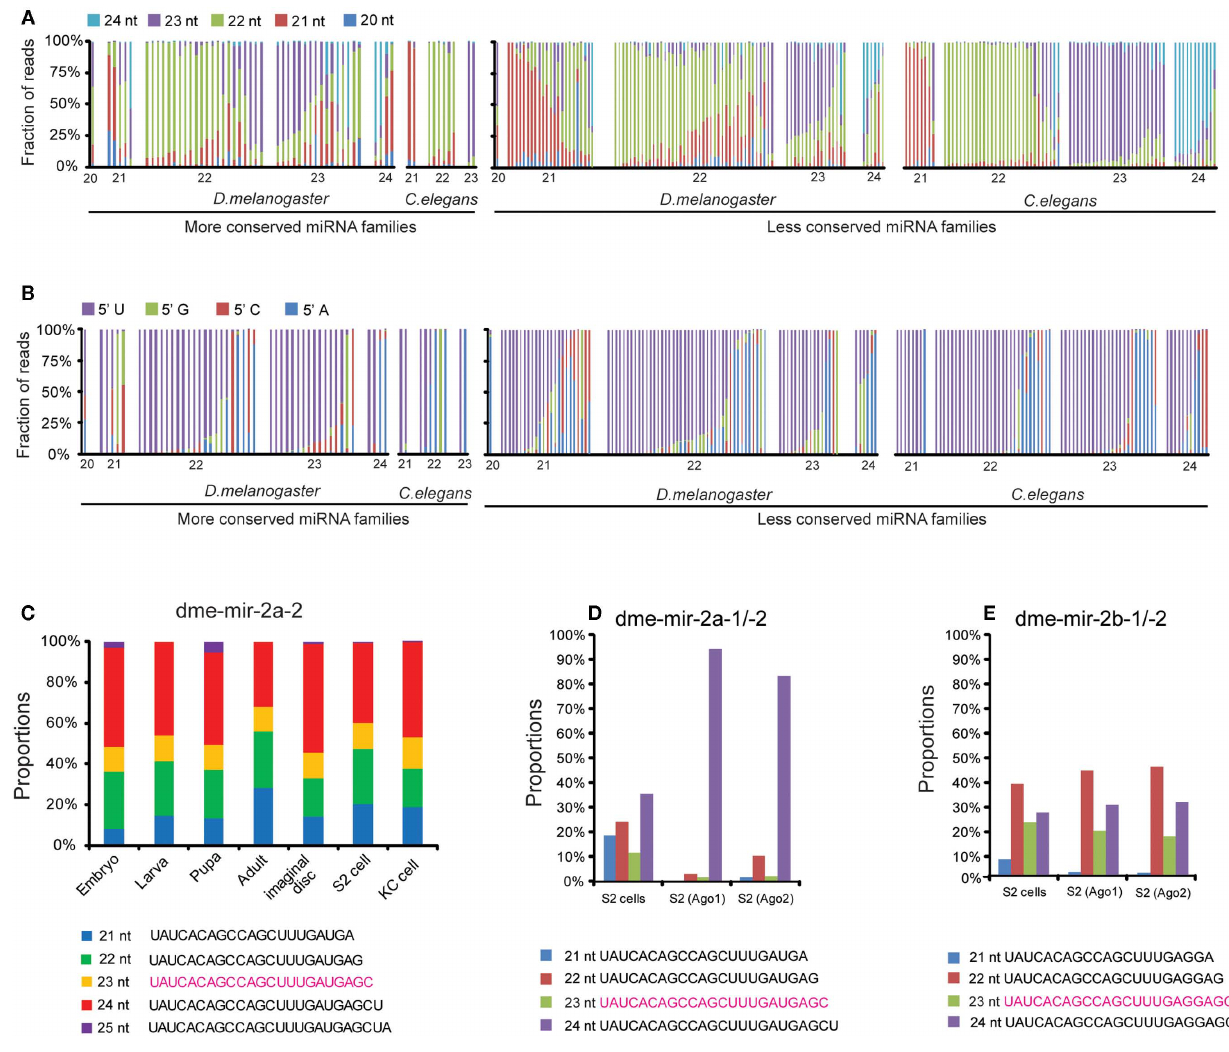
FIGURE 1 | Discrepancies between miRBase annotation and the actual miRNA sequences obtained from smRNA-seq data. (A) Fractions of different sizes of smRNA-reads mapped on each pre-miRNA sequence. Each column represents one miRNA sorted by its size based on miRBase annotated mature miRNA sequence. (B) Fractions of different 5 (cid:2) nucleotides